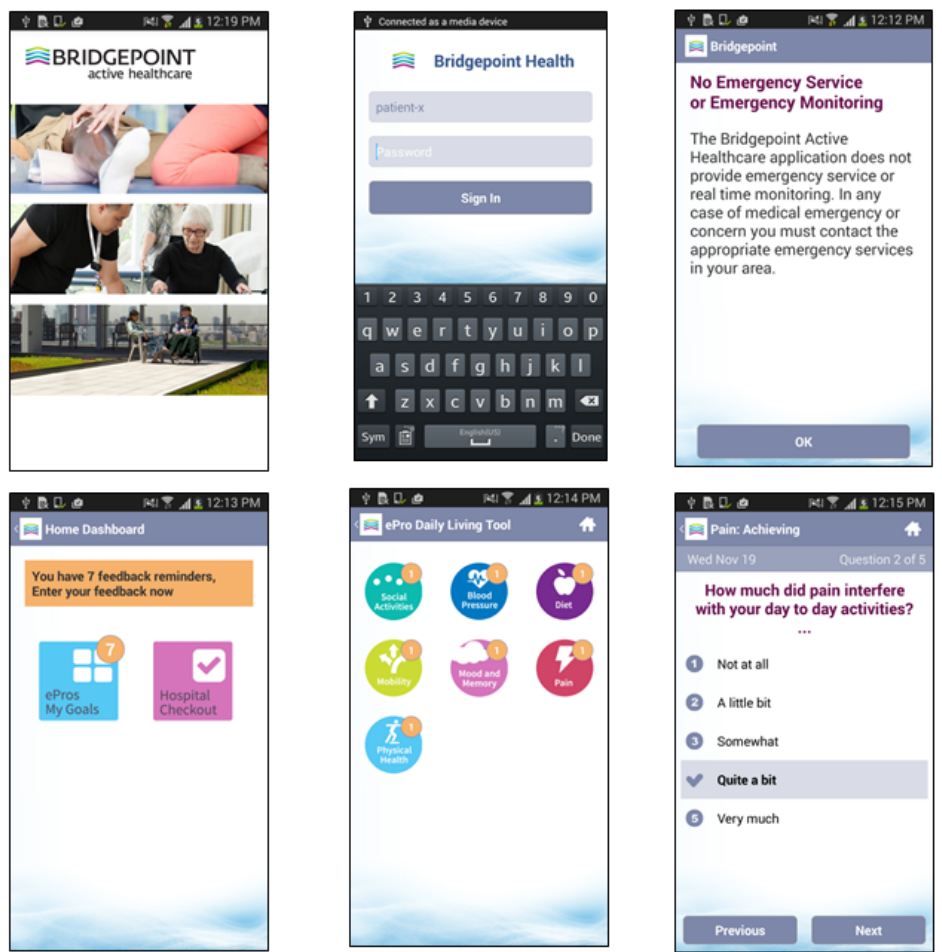
Figure 3. Depiction of the ePRO mobile